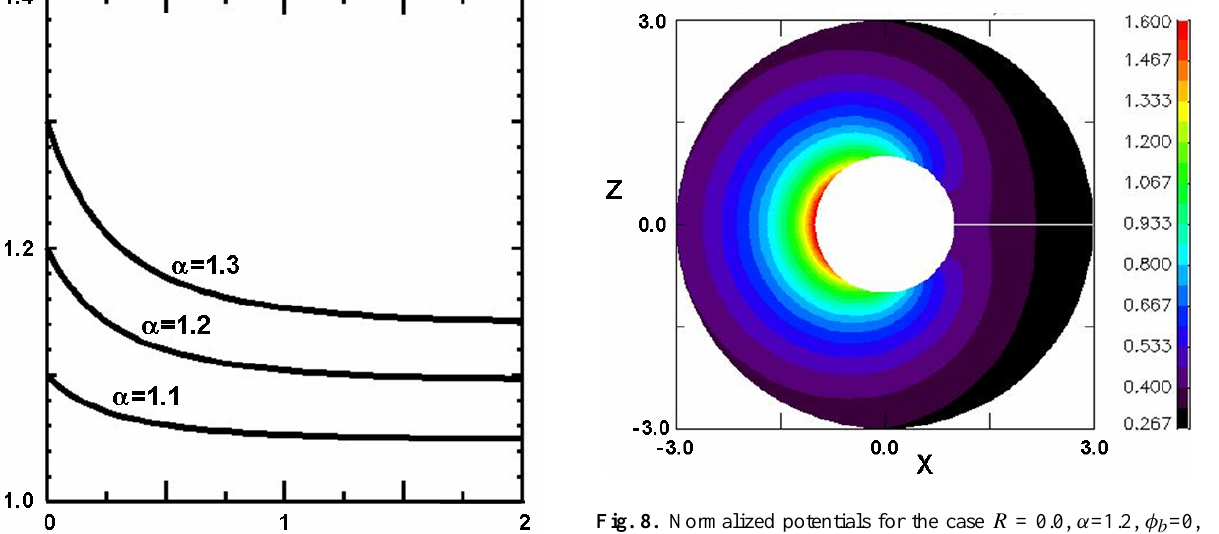
Fig. 8. Normalized potentials for the case R = 0.0, α =1.2, φ b =0, Y=0.